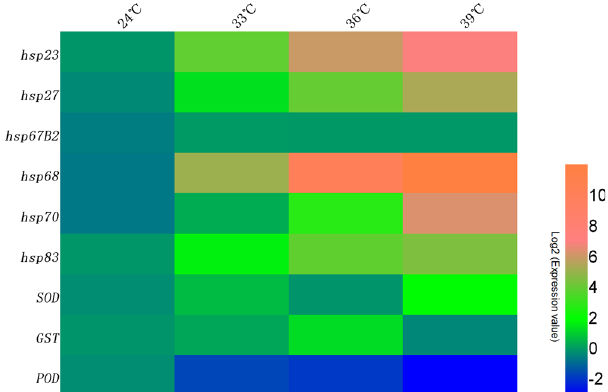
Fig. 5 Effects of temperature stress on mRNA levels of stress and antioxidant genes in Chlorops oryzae larvae. mRNA levels were determined by qRT-PCR. Each gene had three biological replicates. The heat map was generated from log2-transformed expression ratios relative to the mRNA expression of stress and antioxidant genes in the 24 °C control group. Blue: low expression levels. Red: high expression